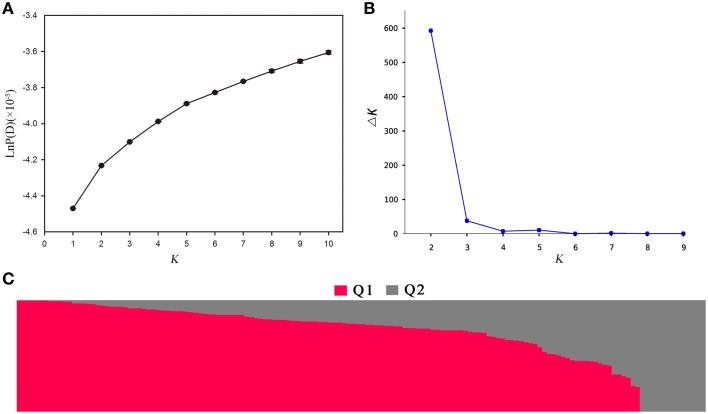
Population structure analysis of 143 rapeseed accessions by STRUCTURE software. (A) The estimated LnP(D) of possible clusters (k) from 1 to 10; (B) Δk based on the change of LnP(D) between consecutive k; and (C) Q1 and Q2 are the composition values belonging to the two sub-populations (K = 2) for a given accession which is represented by a vertical bar.